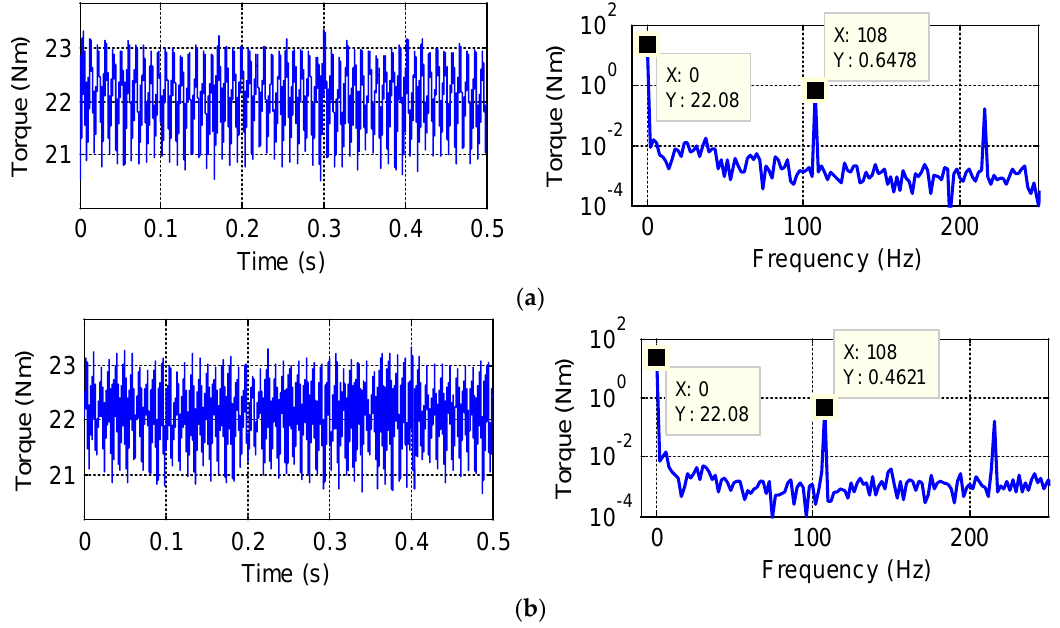
Figure 24 . Torque response of middle shaft of the reducer at motor speed of 270 rpm: ( a ) Before suppression; ( b ) After suppression.